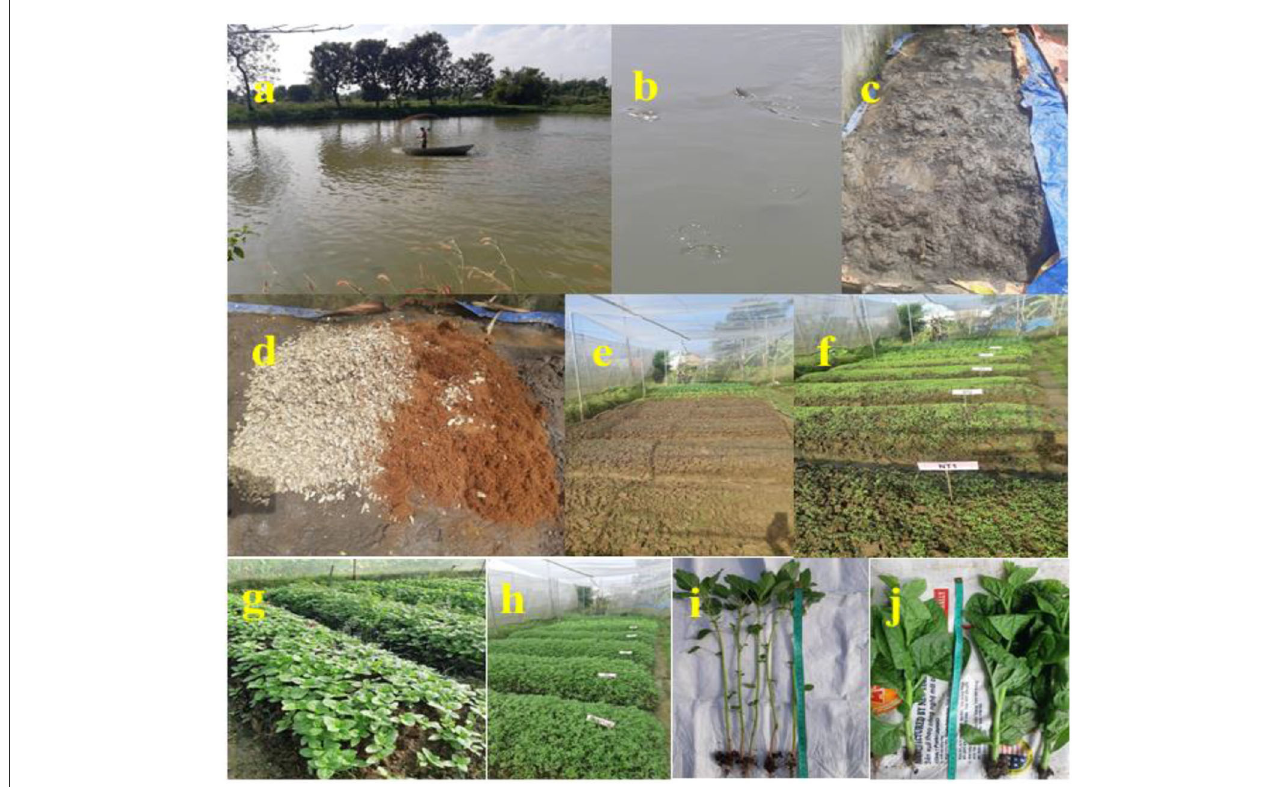
FIGURE3 Schematic outline of organic fertilizer production, experimental vegetable cultivation, experimental management, and harvesting. (a) Snakehead fish pond farming. (b) Sludge/sediment is collected from fish pond. (c) Sludge of fish pond is sun-dried. (d) Sludge/sediment mixed with peanut shells + coir fiber. (e) Experimental plots and soil preparation. (f) Malabar spinach and Amaranthus cruentus planting. (g) Malabar spinach at 20-day after planting. (h) Amaranth after 20 days of planting. (i) Harvested Malabar spinach vegetable. (j) Harvested Amaranthus cruentus